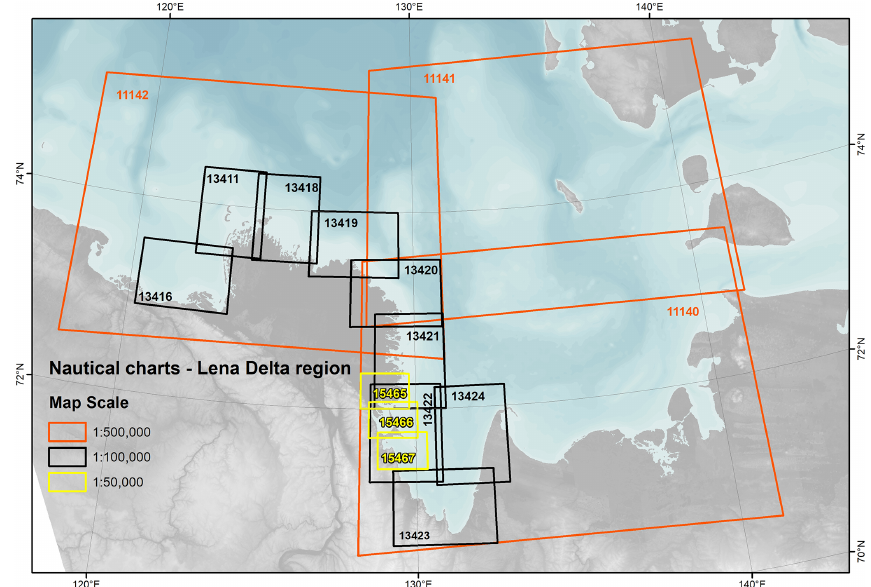
Figure A1. Extent and scale of the nautical charts used for the bathymetrical models in the Lena Delta region. Chart numbers are indicated on the map. More details on the charts can be found in Table 1. The background map is the IBCAO v4 data from Jakobsson et al. (2020).